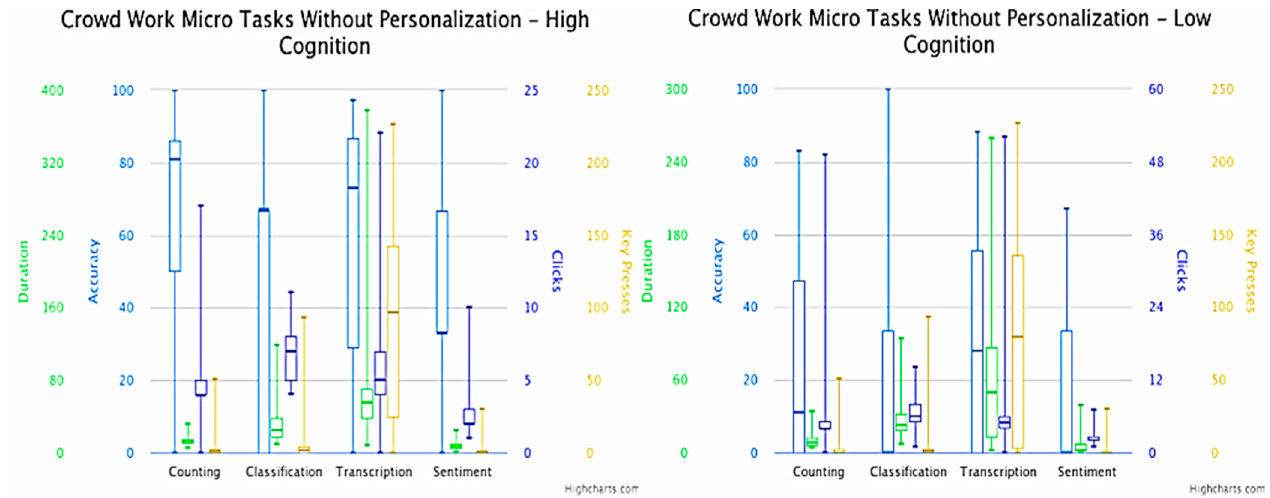
Figure 3. Box plot of microtask performance without personalization (normal difficulty) for crowd workers with a cognitive ability score equal or above median ( left )/below median ( right ).